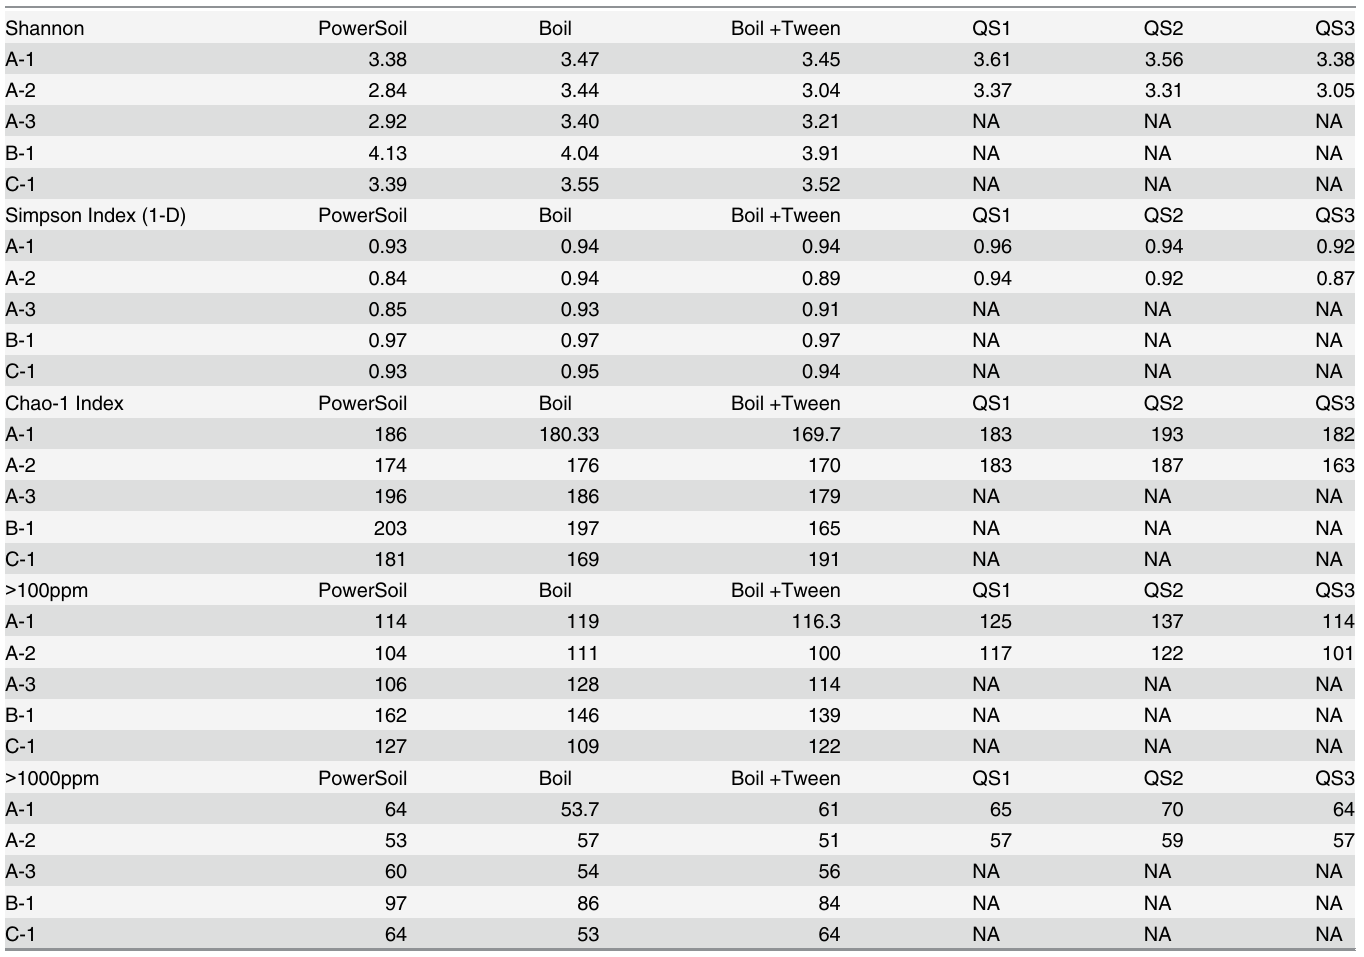
Table 2. Index of α -diversity for each DNA extraction